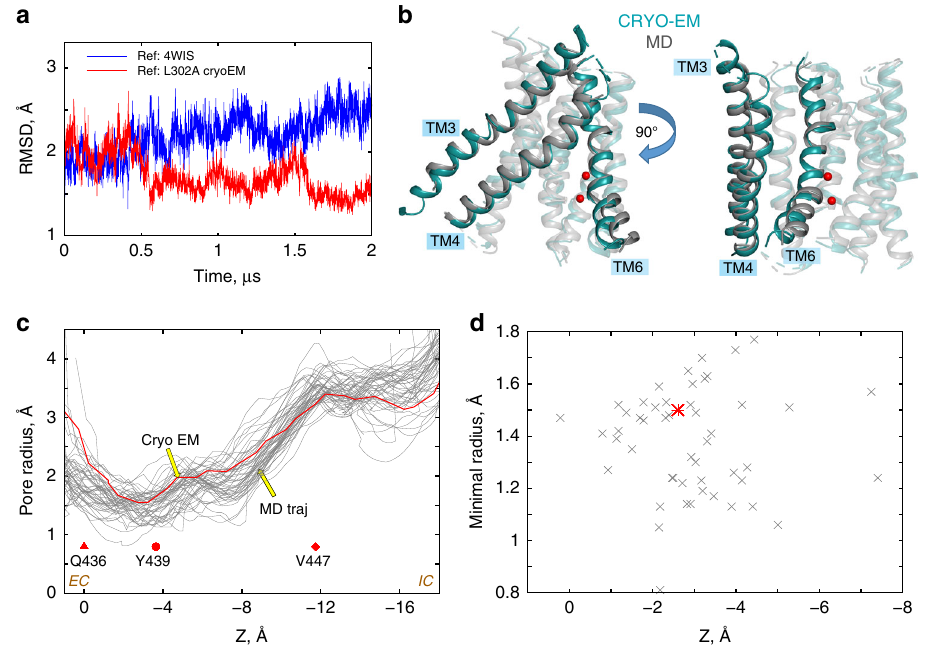
Fig. 8 Structural similarity between the cryo-EM and computationally predicted models of the L302A nhTMEM16. a Time-evolution of the backbone RMSD of the TM helices for one monomer of the L302A nhTMEM16 from a 2 µ s-long MD simulation (Supplementary Table 1) with respect to either the cryo-EM model of L302A nhTMEM16 (red), or the X-ray structure of the WT nhTMEM16 from PDBID: 4WIS 7 . b Superposition of the TM helices of L302A nhTMEM16 of the cryo-EM model (teal) with the average structure from the last 500 ns timeframe of the MD trajectory (gray). The backbone atom RMSD over all 10 TM helices is 1.2 Å. TM3, TM4, and TM6 helices are opaque and labeled, whereas the rest of the TM-s are shown in transparent. The Ca 2 + ions from the cryo-EM structure are shown as red sphere. c The pore radius as a function of position along an axis perpendicular to the membrane (channel coordinate) for the cryo-EM structure of L302A (red line), and for 50 evenly spaced frames from the last 500 ns of the 2 μ s MD simulation of the L302A from ( a ) (gray lines). The EC and IC ends of the pore are indicated, and Z = 0 Å corresponds to the location of the C α atom of residue Q436 (red triangle symbol), the dot marks the position of the C α atoms of residue of Y439, and the diamond symbol that of V447. The calculations were performed with the program HOLE (http://www.holeprogram.org/). d Values of the minimal radius of the pore versus the value of the channel coordinate at which the pore radius is minimal. The calculations are from the HOLE pro fi les shown in ( c ) (the red colored data point corresponds to the minimum in the cryo-EM structure pro fi le; see red line in ( c